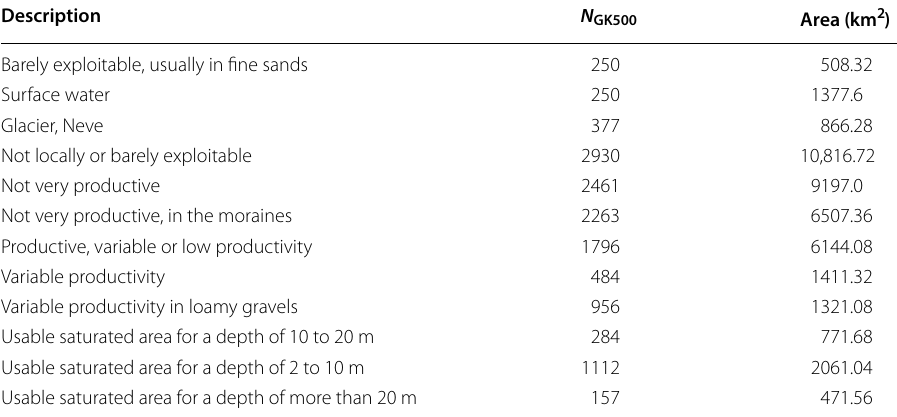
Table 6 Aquifer productivity [PRODUCTIV] categories in GK500 dataset